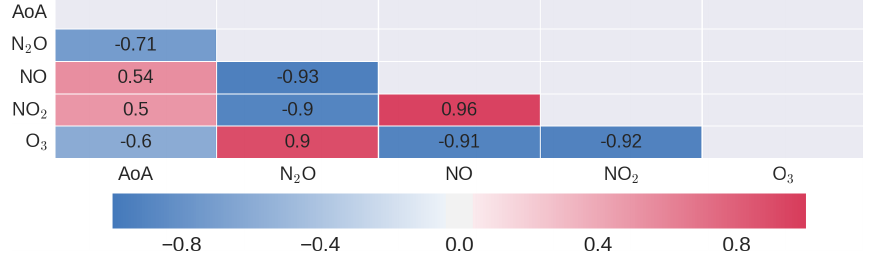
Figure 6. Correlation heat map for monthly means of AoA, N 2 O, NO, NO 2 , and O 3 from TOMCAT CNTL run for the period January 2004– April 2012 in the tropical mid-stratosphere. Repeated information was excluded from the heat